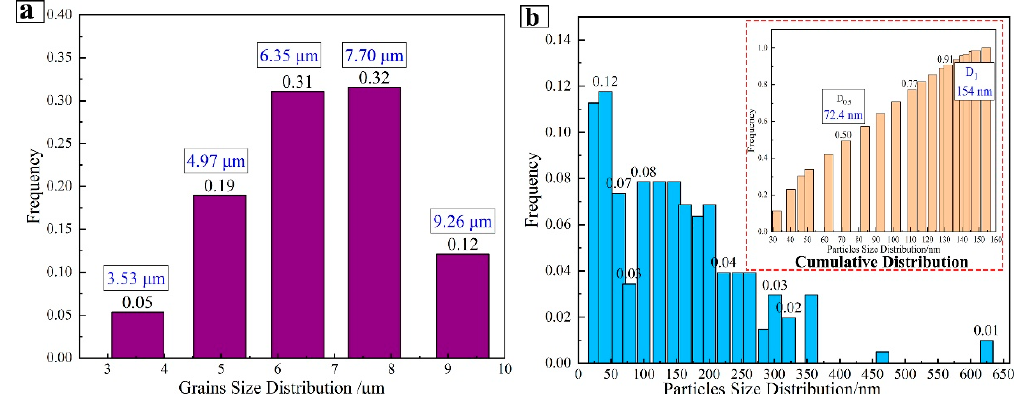
Figure 4. The microstructure of SPS Mg 96.9 Gd 2.7 Zn 0.4 bulk. ( a – b ) SEM images (secondary electron mode), and ( c – e ) BF-TEM images, the boundaries of ribbons and β 1 phase particles and LPSO phase are indicated by arrows.